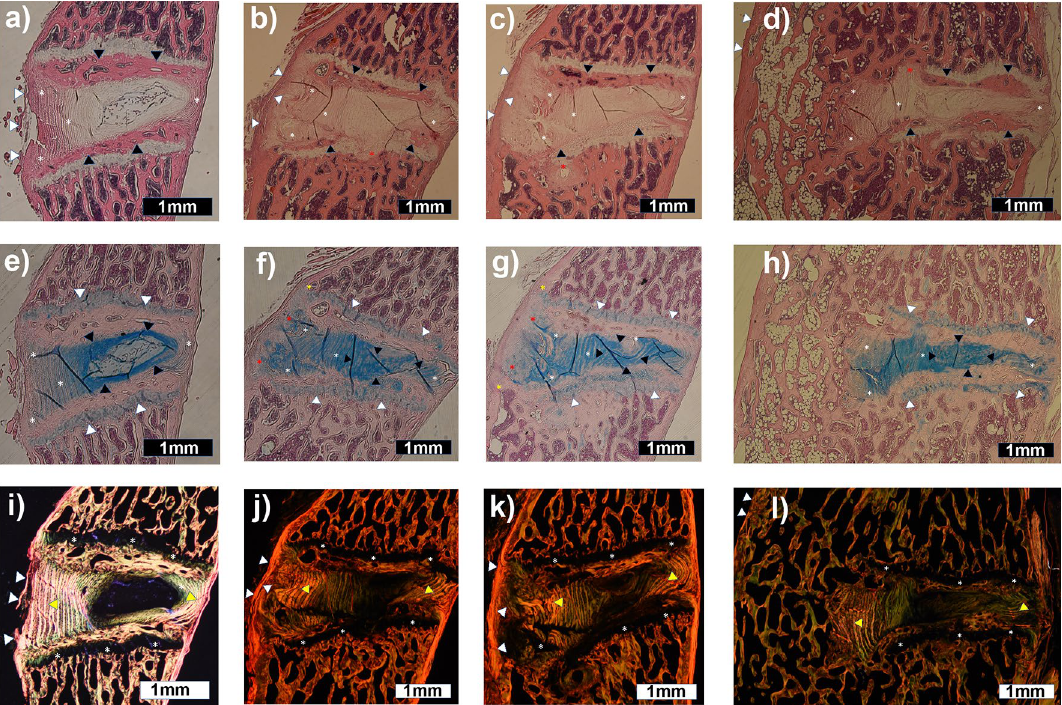
Figure 3. Microscopic morphology of fusion bone and intervertebral disc space tissues 12 weeks after intradiscal implantation of genetically programmed bone marrow stromal cells. Spines were explanted, decalcified, paraffin embedded, sagittal sectioned, and assessed for: general architecture (H&E stain— A , B , C and D ), proteoglycan/cartilage (Alcian Blue stain— E , F , G and H ), or collagen (Picrosirus Red stain and circular polarized light— I , J , K and L ). Representative images from specimen 29 from a non-operated normal L3/4 level ( A , E and I ), specimen 26 LACZ (marker gene)-treated L4/5 level ( B , F and J ), specimen 29 BMP2 and BMP7 homodimer (HD)-treated L4/5 level ( C , G and K ), and specimen 24 BMP2/7 heterodimer (HT)- treated L5/6 level ( D , H and J ) are shown. H&E stained images are marked to show: anterior longitudinal ligament (ALL) (white triangle) (partially discontinuous distally as an artifact of preparation in A), annulus fibrosus (AF) (white asterisks), and epiphyseal bony endplates (black triangle). Alcian Blue stained images are marked to show: endplate growth plates (white triangle), anterior and posterior AF lamellae (white asterisks), and nucleus pulposus (NP) (black triangle). Picrosirus Red polarized images are marked to show: bright yellow/ red and green coloring of high collagen content structures (ALL [as white triangle], AF [as yellow triangle], and vertebral body bone network) and black coloring of low collagen content (growth plates [as white asterisks], NP space, and bone marrow compartments in the vertebral bodies). ( A )–( H ) shows annulus fibrosus (AF) and nucleus pulposus (NP) are well stained and generally preserved. ( A ) and ( E ) shows the non-operated NP has a central volume that stains lighter with Alcian Blue and contains small eosinophilic (physaliphorous) cells, which are not seen in the more homogeneously dark blue staining NP compartments of the operated levels ( B – D and F – H ). Note scar formation and disorganization of the bony and cartilaginous growth plate epiphyses (red asterisks in B , C and D ) at what were interpreted to be endplate puncture sites. Comparing ( E ) with ( F ) and ( G ) shows additional operative changes including: new cartilage-appearing cells between the ALL and anterior fibers of the AF (red asterisks) staining similarly and in apparent continuity with the cartilaginous growth plate, and new vertebral body bone extending anterior to the anterior AF that is minor in Panel F but more noticeable in G (yellow asterisks). D & H shows impressive bone production anterior to the disc space in an HT treated specimen, contiguous with the marrow space, and fatty appearing marrow. Segments are shown with top left of sections being ventral and proximal, magnification at 20 × , and scale bar representing 1